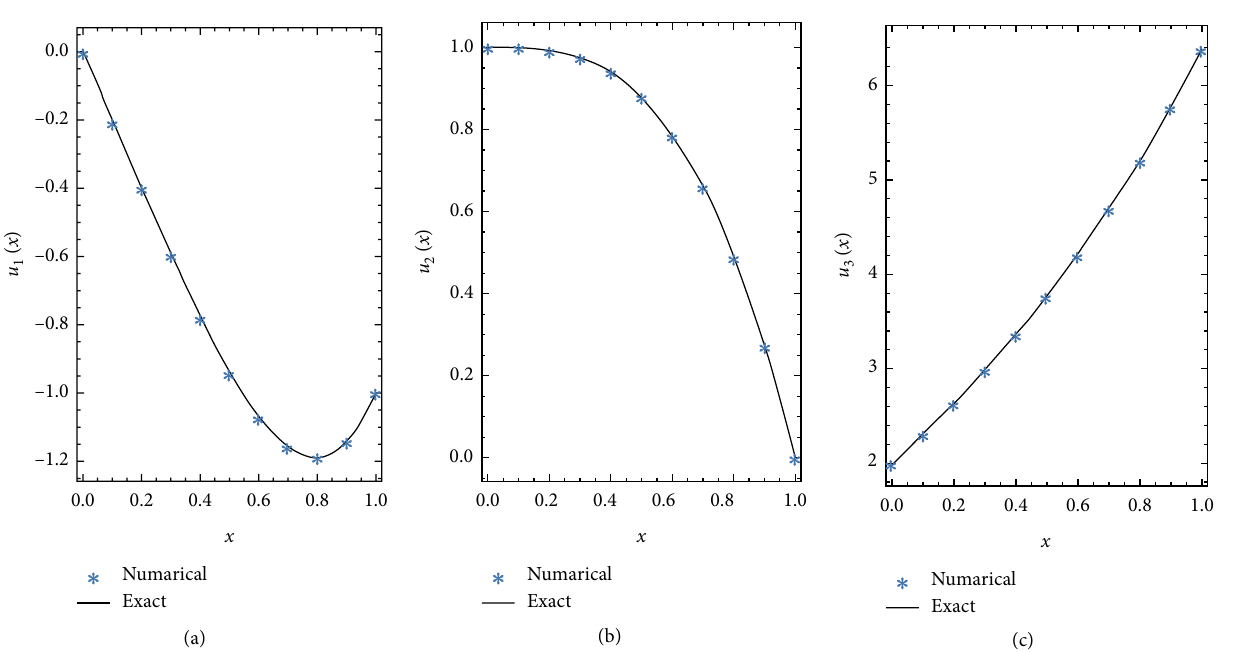
Figure 2: A comparison between exact and numerical solutions by applying Algorithm 1 for system (66) with . (b) The exact and numerical solutions of numerical solutions of 𝑢 1